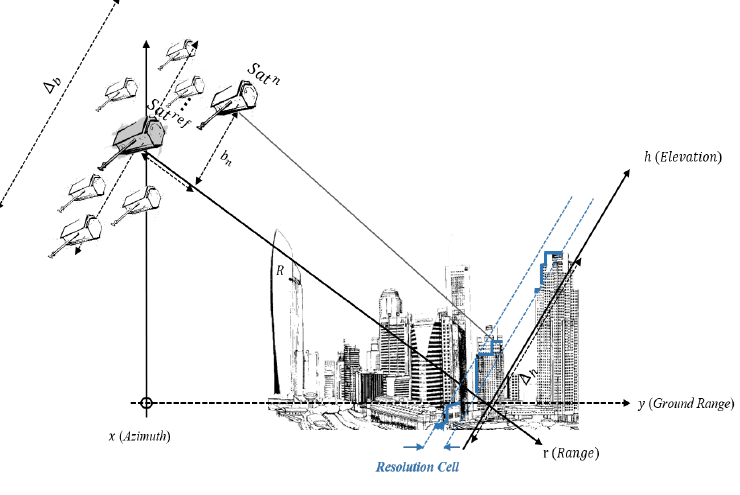
Figure 1. TomoSAR